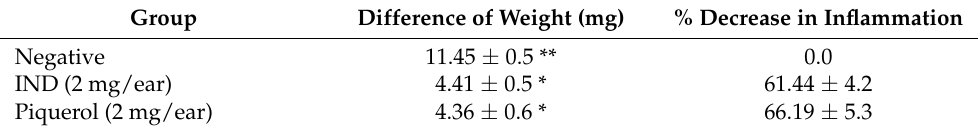
Table 1. Acute anti-inflammatory activity: edema induced by